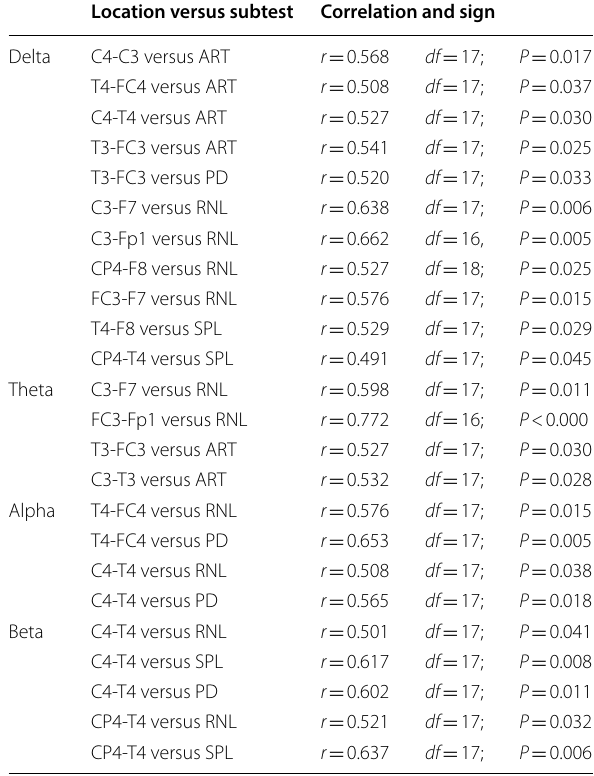
ART articulation, PD phoneme deletion, RNL rapid naming letters, SPL spelling